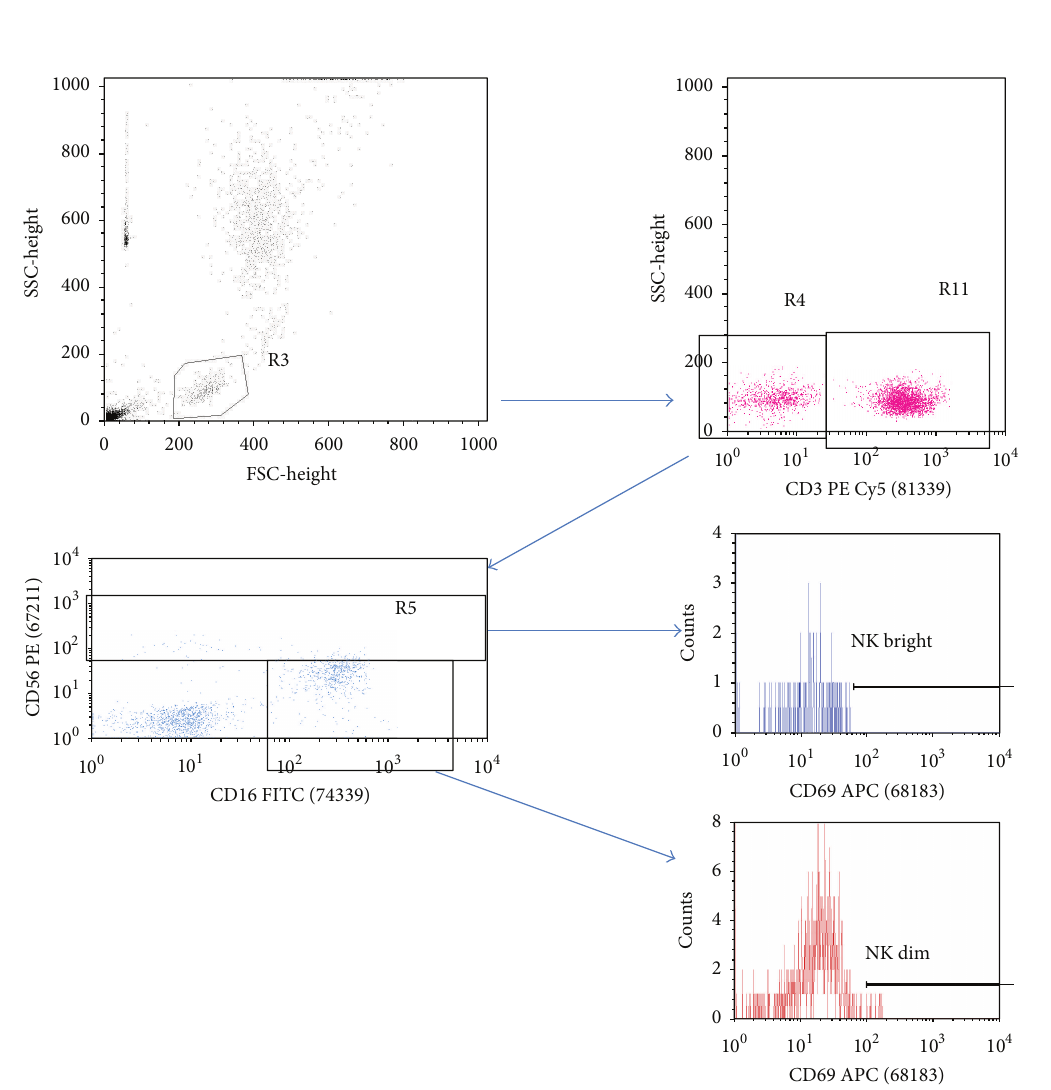
Figure 1: Gating strategy for NK CD69 enumeration: lymphocytes were identified using FSC/SSC and the CD3 negative population was identified. They were further classified into CD16 positive and either CD56 dim or CD56 bright. Each of these populations was then interrogated for CD69